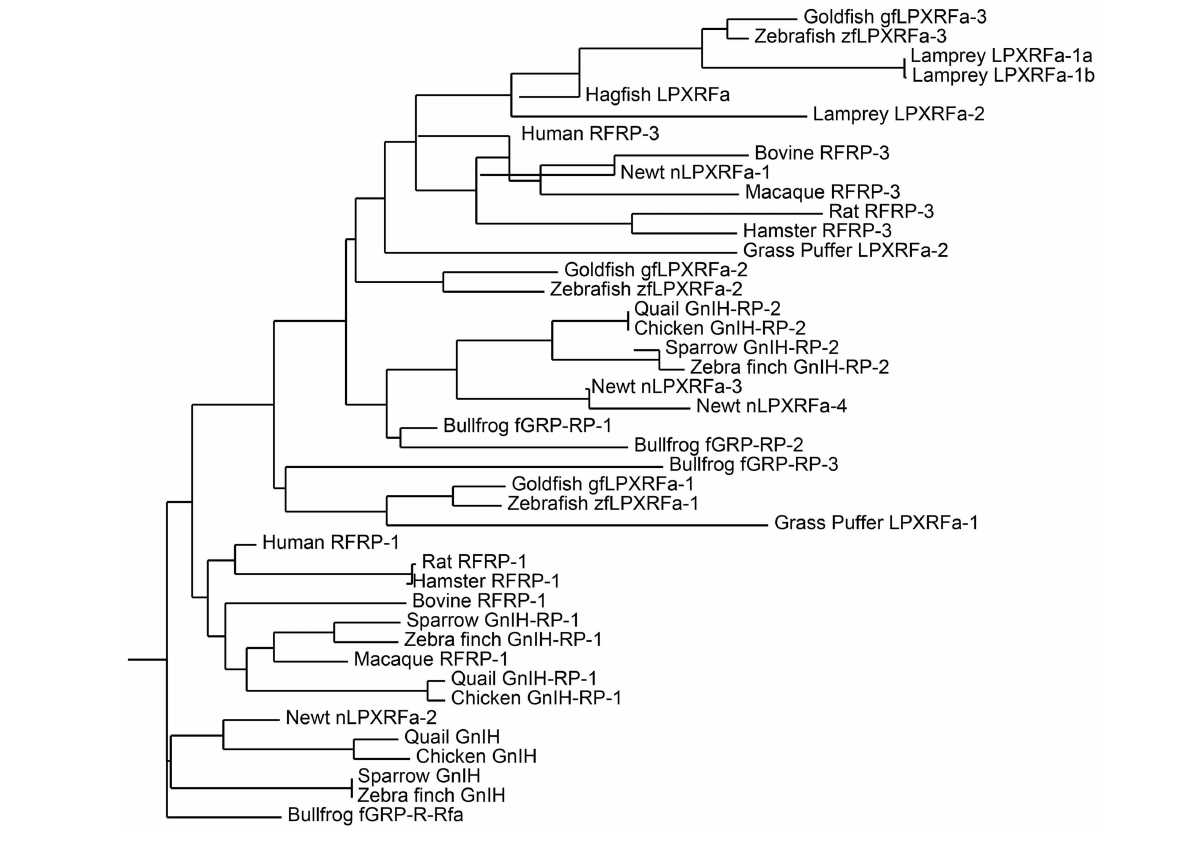
FIGURE 1 | Phylogenetic tree of GnIH and its homologous peptides sequences in vertebrates .The phylogenetic tree was constructed by MEGA 3.1 using the neighbor-joining method.The amino acid sequences analyzed for the phylogenetic tree construction are listed in Table 1